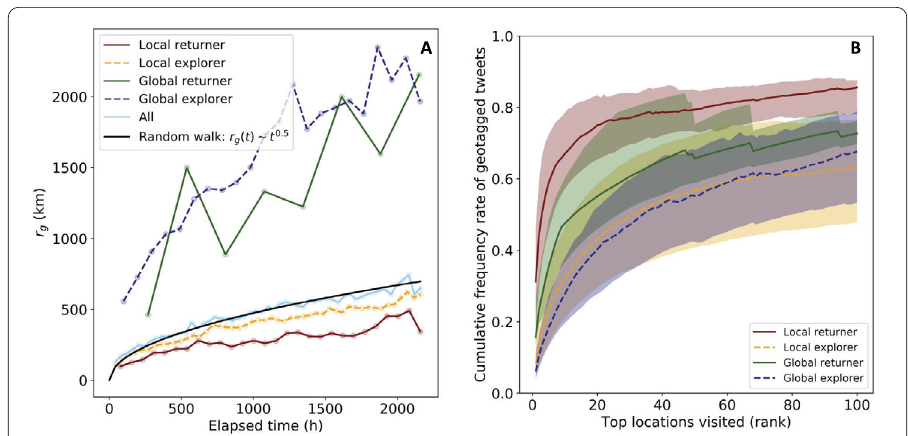
Figure 10 Diffusion process. ( A ) Time history of radius of gyration within 90 days. The time history starts from the first time observing the most visited location; each data point indicates the mean value of r g across the same group of users. ( B ) Visiting frequency by the ranking order of the most visited locations. The shaded range indicates the upper bound (75%) and lower bound (25%) of the cumulative frequency rate of